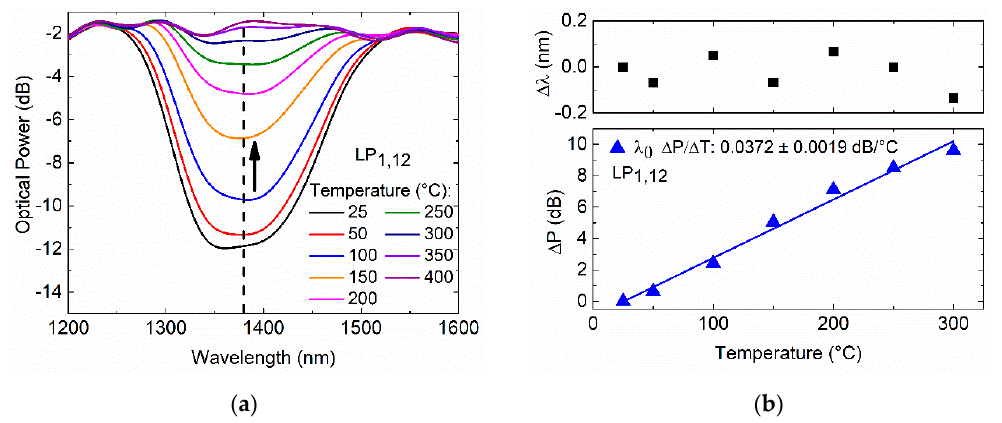
Figure 8. Fs-laser TAP LPFG inscribed with a period of 182.7 µm: ( a ) transmission spectra at annealing temperature; ( b ) normalized wavelength shift ( ■ ) and optical power variation ( ▲ ) as a function of the annealing temperature.